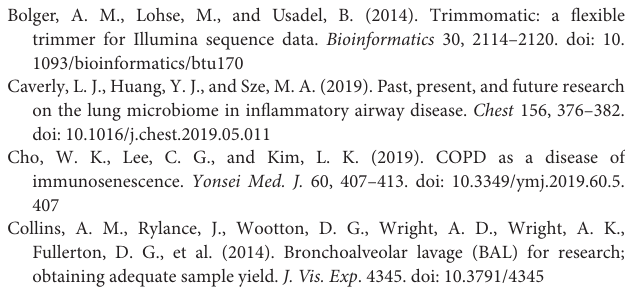
Supplementary Figure 1 | The microbiomes compositional profiles of the AECOPD patients and stable COPD (stabilization of AECOPD patients after treatment) patients. The stacked bar represents differentially relative abundance of microorganisms in the AECOPD vs. stable COPD groups. (A,B) shows the relative abundance of the most dominant taxa at the class levels in metagenomic data (A) and metatranscriptomic data (B) . (C,D) shows the most dominant taxa distributions at the order levels of the sputum microbiomes in metagenomic data and metatranscriptomic data. (E,F) shows the most dominant taxa distributions at the family levels of the sputum microbiomes in metagenomic data and metatranscriptomic